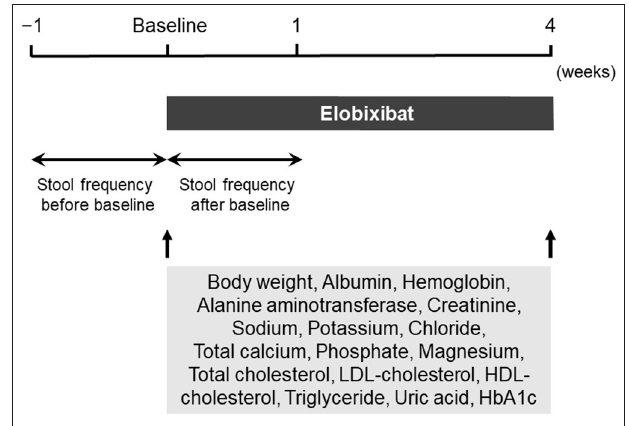
FIGURE 1 | Study design diagram. HbA1c, glycosylated hemoglobin; HDL, high-density lipoprotein; LDL, low-density lipoprotein.